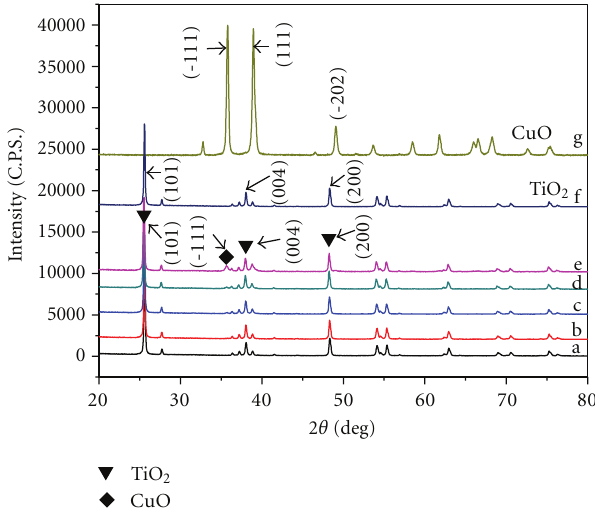
Figure 1: XRD patterns of di ff erent photocatalysts. (a) F-TiO 2 , (b) CuO (0.1 wt.%)/F-TiO 2 , (c) CuO (1.0wt.%)/F-TiO 2 , (d) CuO (5.0wt.%)/F-TiO 2 , (e) CuO (10.0 wt.%)/F-TiO 2 , (f) TiO 2 , and (g)